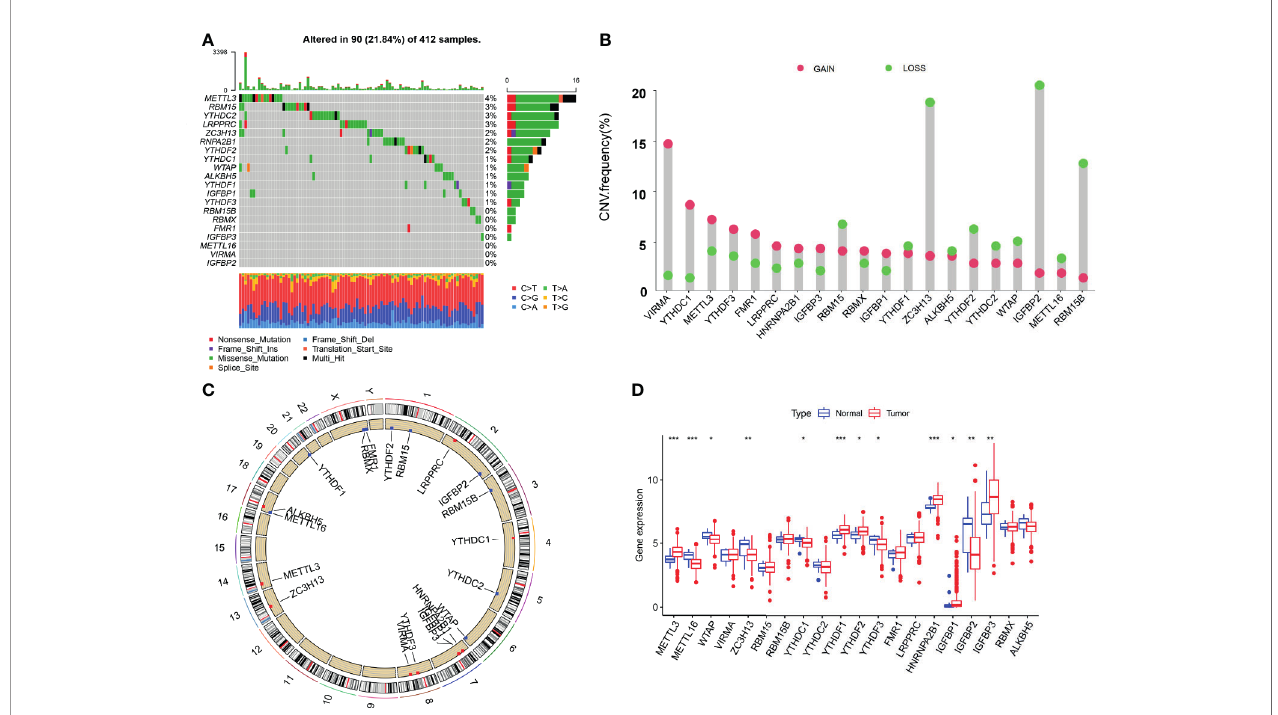
FIGURE 1 | Genetic landscape and expression changes of the m6A regulator in bladder cancer. (A) Mutation frequency of the m6A regulators of bladder cancer patients in the TCGA-BLCA cohort. (B) A histogram plotting the mutation frequency of each gene obtained by statistical analysis of the copy number of m6A. The abscissa was the m6A-related gene, and the ordinate was the mutation frequency. Red represents an increase in copy number, and green represents loss of copy number. (C) The m6A copy number circle graph. Red represents the sample with missing gene copy number than the sample with increasing copy number. Green represents the sample with missing gene copy number than the sample with increasing copy number. (D) The box plot of m6A differential expression analysis. Red represents the tumor sample, and green represents the normal sample. The *** represents p < 0.0001, ** represents p < 0.01, * represents p <